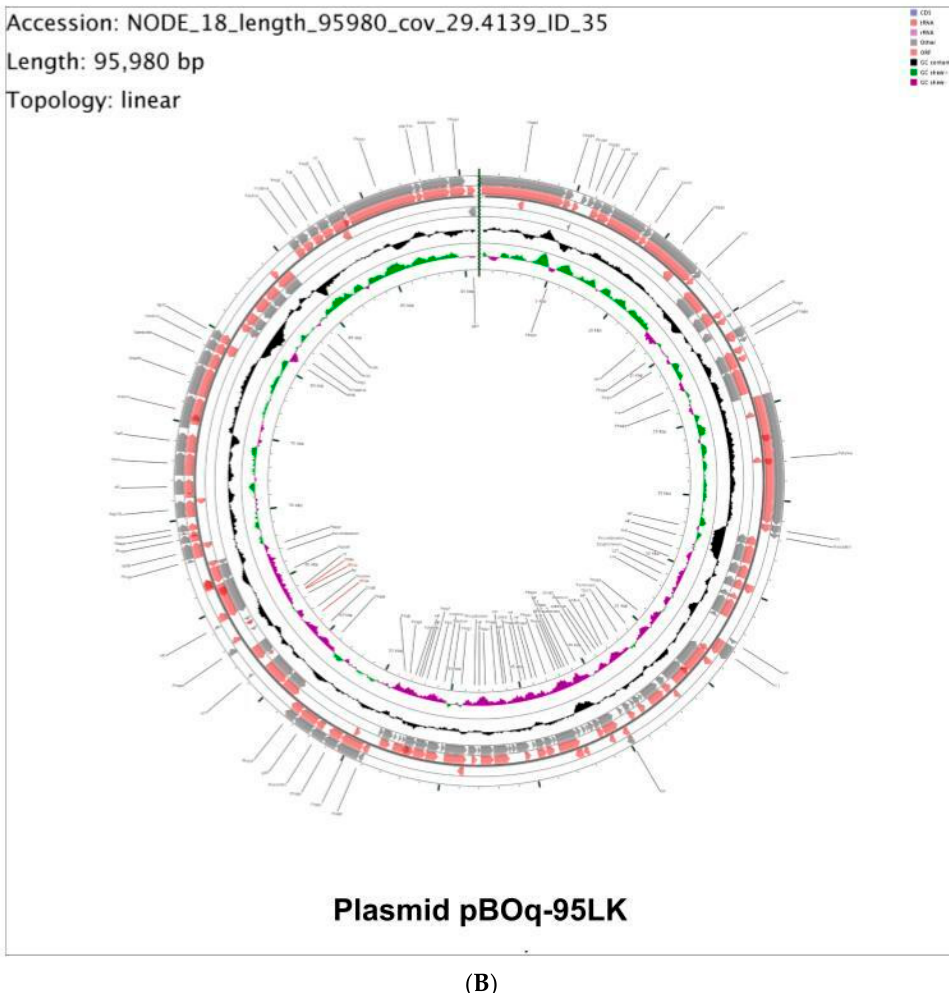
Figure 2. ( A ) Physical map of plasmid pBOq-IncQ from E. coli BOq 01 strain. ( B ) Physical map of plasmid pBOq-95LK from E. coli BOq 01 strain.